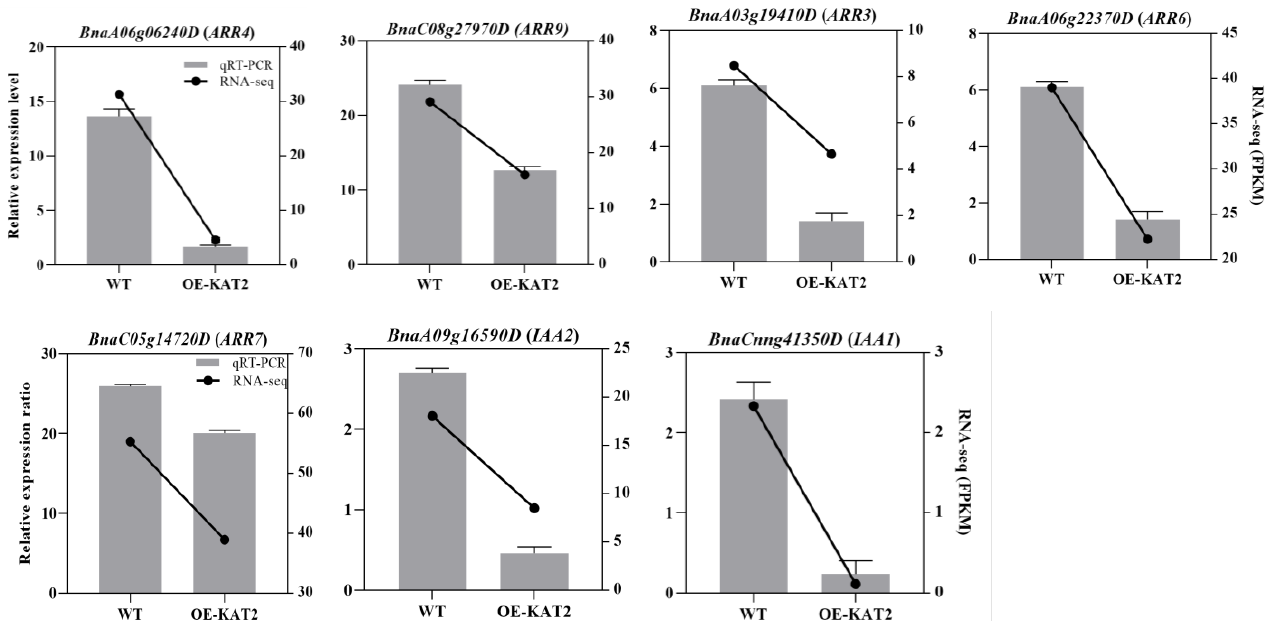
Figure 6. qRT-PCR verification of some of the DEGs identified in the RNA-seq analysis. The relative expression values for the RNA-seq data are the average fragments per kilobase of exon per million mapped fragments (FPKM) values of three biological replicates. The qRT-PCR value represents the mean relative expression values. Values suggest means ± SD of three independent biological replicates.